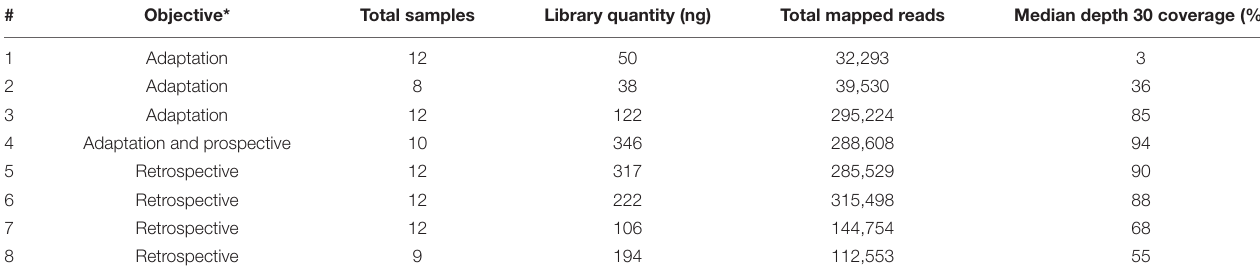
TABLE 1 | Additional details on sequencing runs.